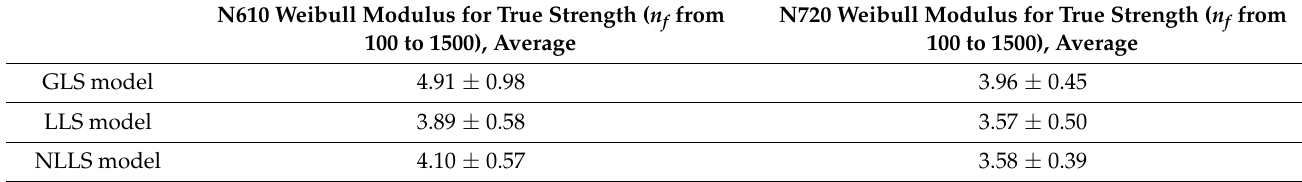
Table 7. Average Weibull modulus for the True Strength of N610 and N720 virtual bundles under different load-sharing models.